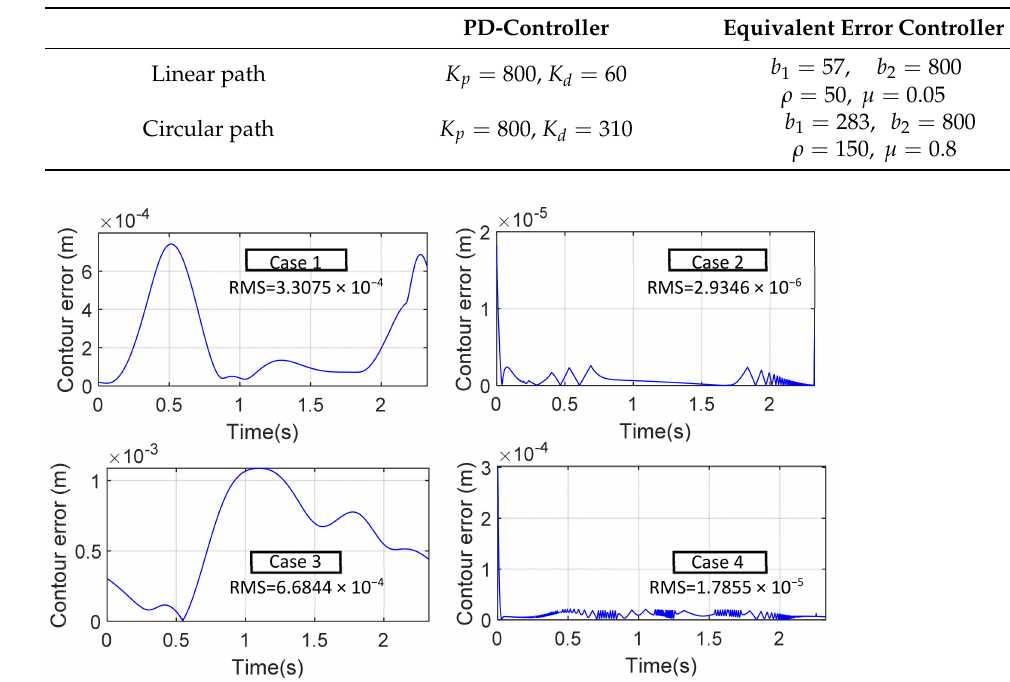
Table 2. The control parameters of simulation cases.